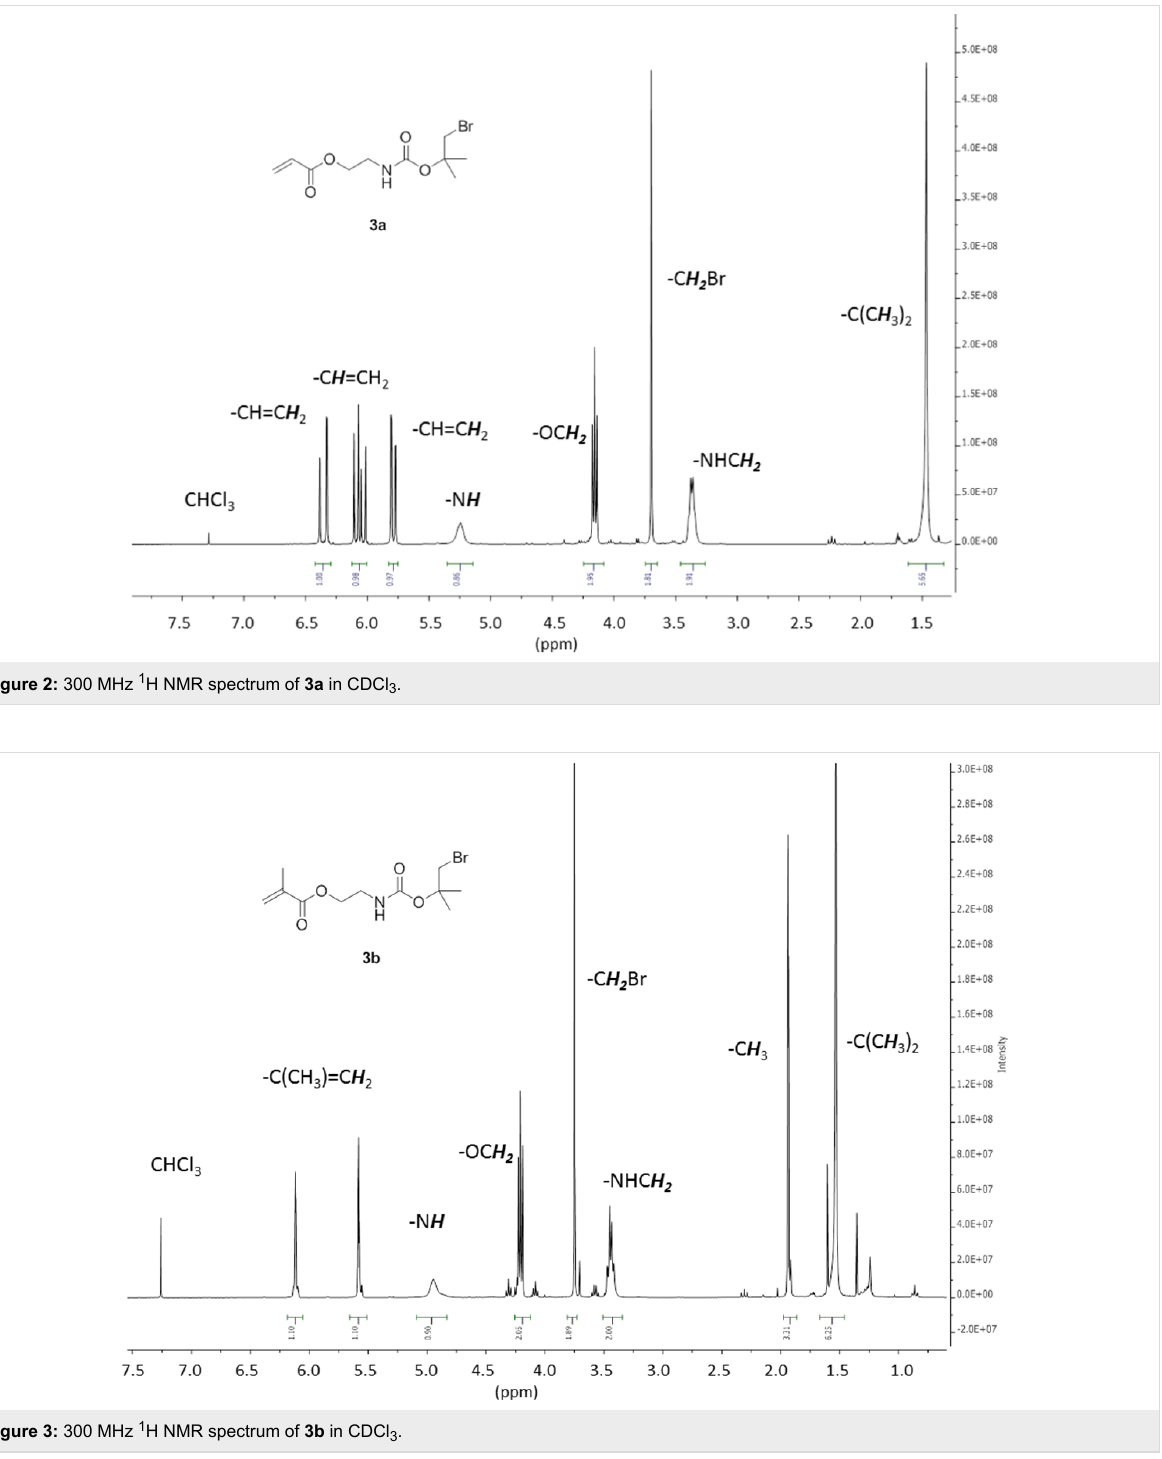
Figure 3: 300 MHz 1 H NMR spectrum of 3b in CDCl 3